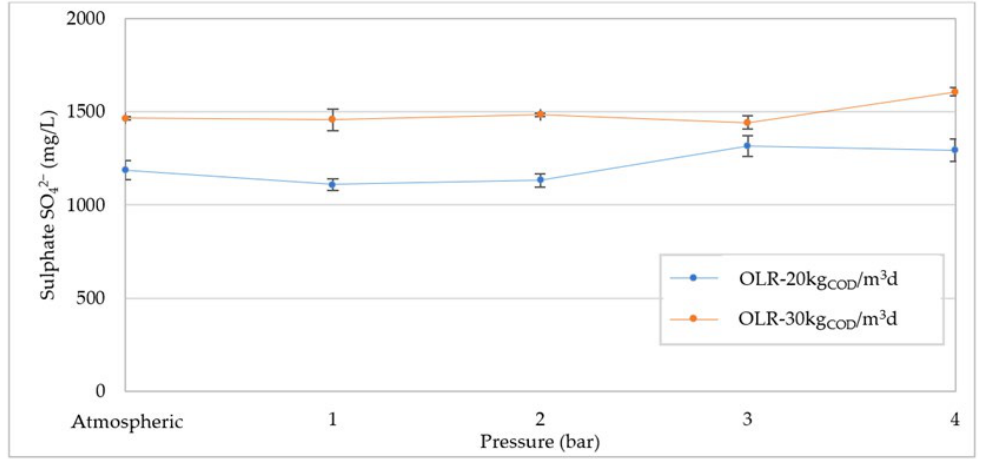
Figure 11. Sulphate (SO 42 − ) concentration at pressure increases for organic load rate (OLR) of 20 kg COD /m 3 d and 30 kg COD /m 3 d.